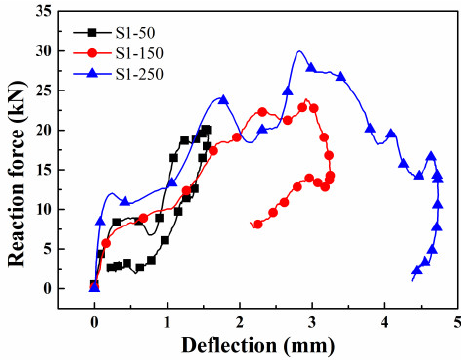
Figure 12. The reaction force versus mid-span deflection.